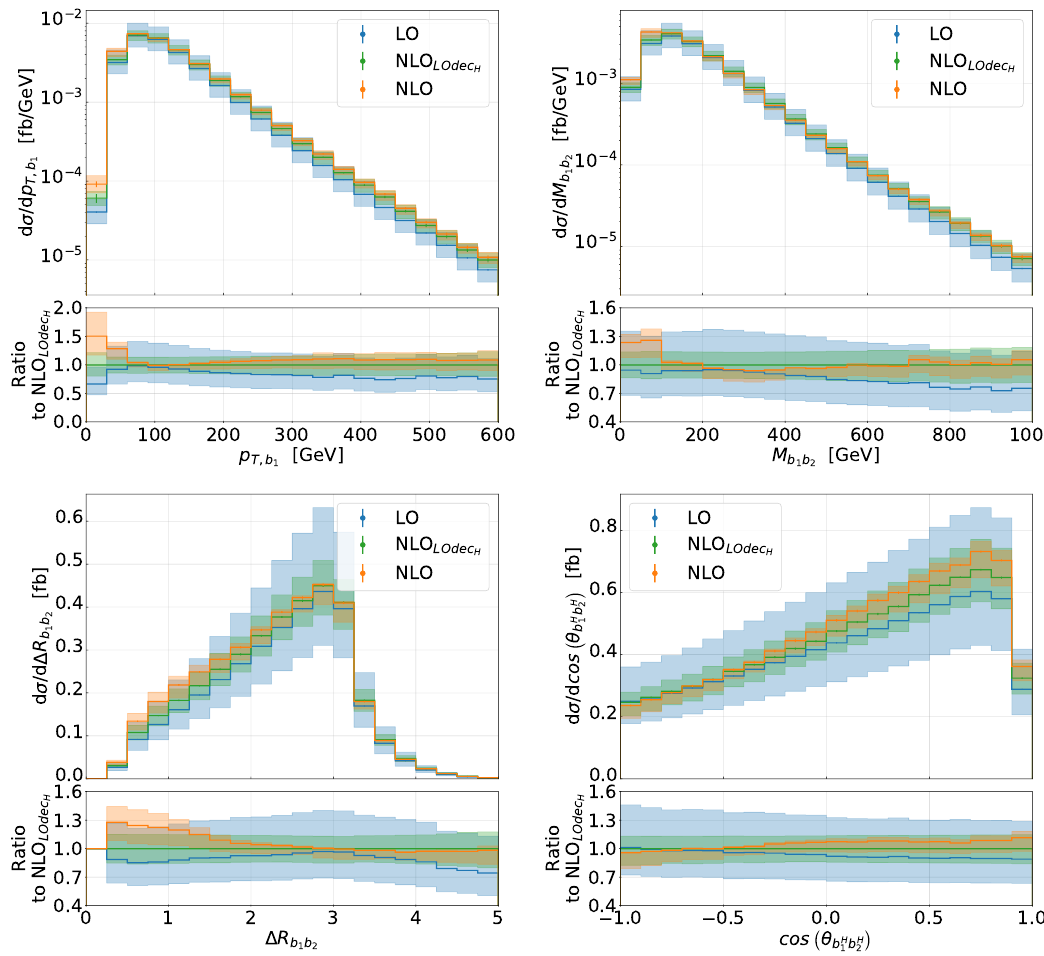
Figure 15 . Differential distributions for the observables p T,b the pp → e + ν e µ − ¯ ν µ b ¯ b H ( H → b ¯ b ) process at the LHC with µ 0 = H T / 2 and µ R, dec = m H . The NNPDF3.1 PDF set is employed. We show predictions at LO, NLO LOdec and NLO. Also given are Monte Carlo integration errors. The lower panels display the H ratio to the NLO LOdec H